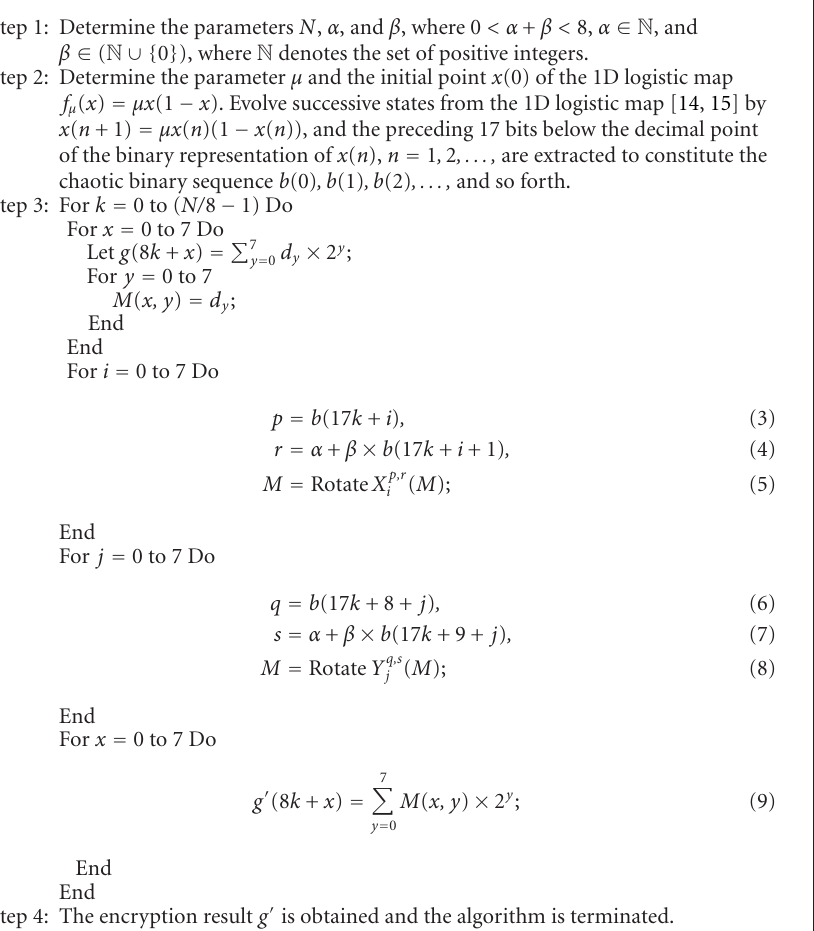
Algorithm 1: The two-dimensional circulation encryption algorithm